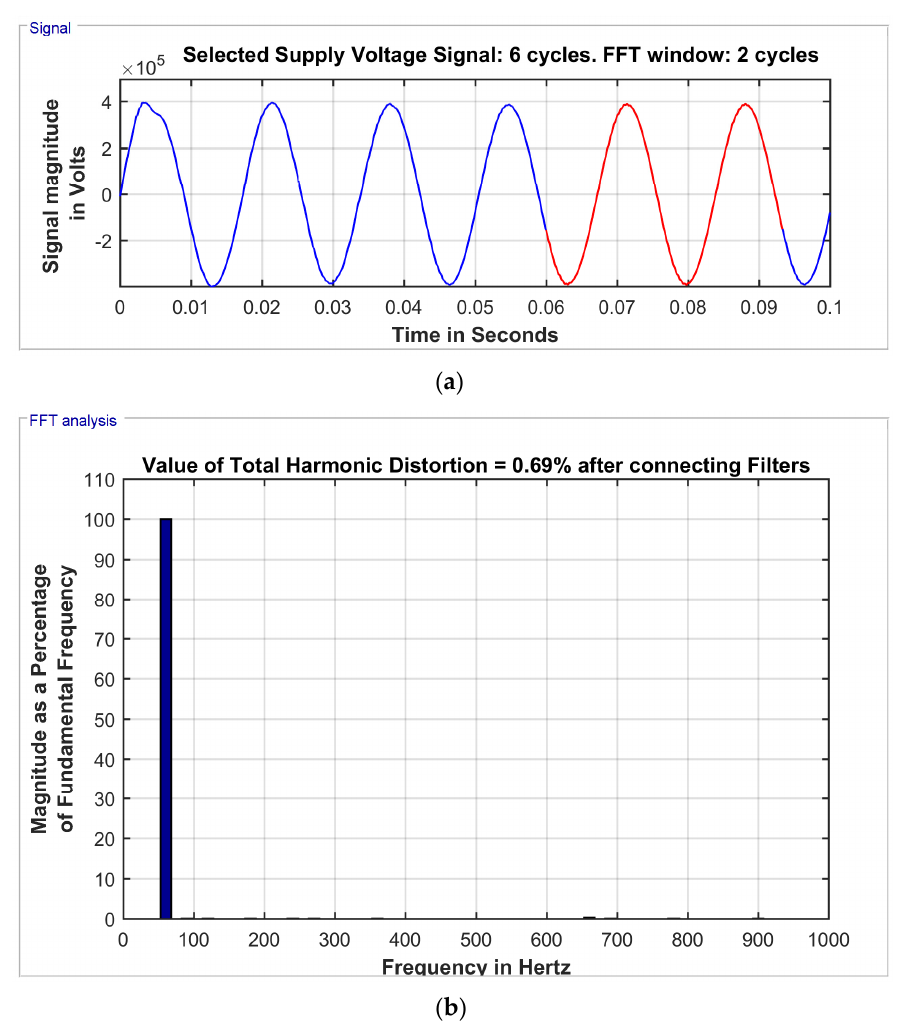
Figure 14. After connecting harmonic filters; ( a ) supply voltage and ( b ) plot of FFT analysis.